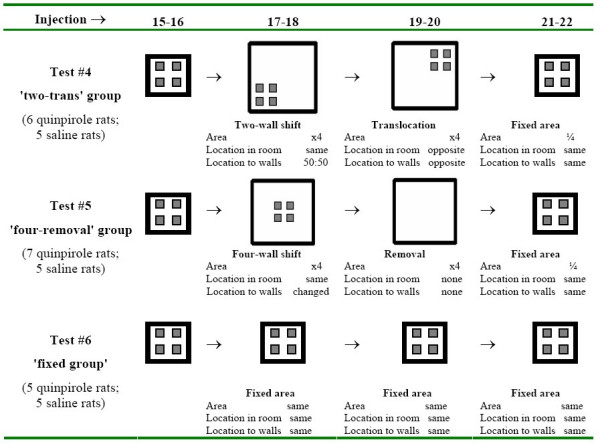
Experimental design of wall shifting and object translocation or removal. The properties of each change in environmental settings are outlined, compared with the starting (injections 15–16) and final (injections 21–22) settings. Saline-treated rats were tested, as indicated for each test group, but their data are not shown since they were hypoactive.